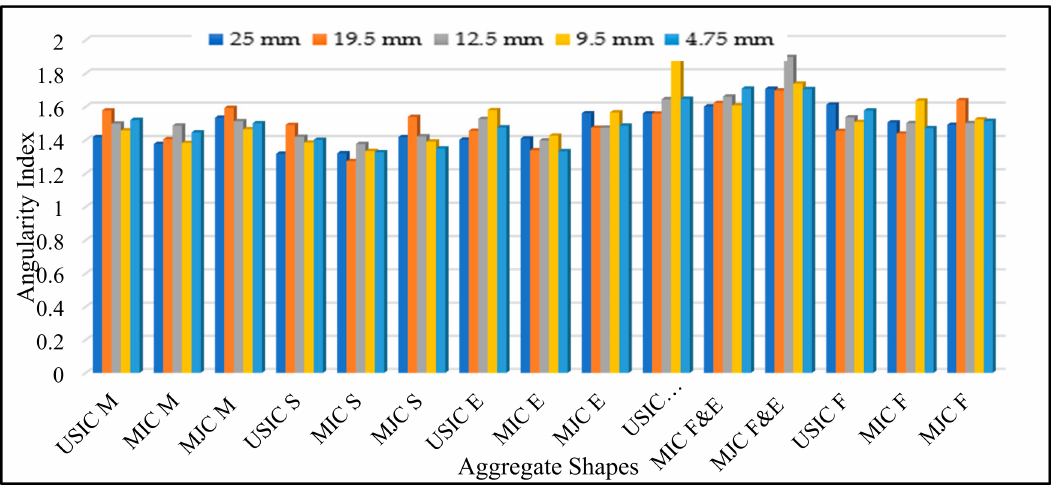
Figure 10. Angularity index of different aggregate shapes and types of